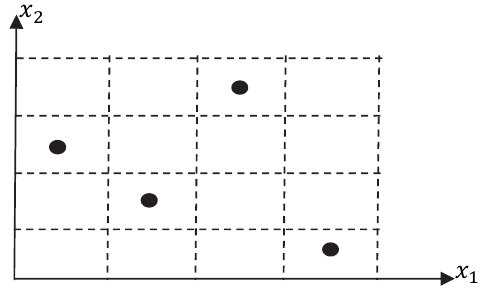
Fig. 9. An example for LHS design with two input factors, and four